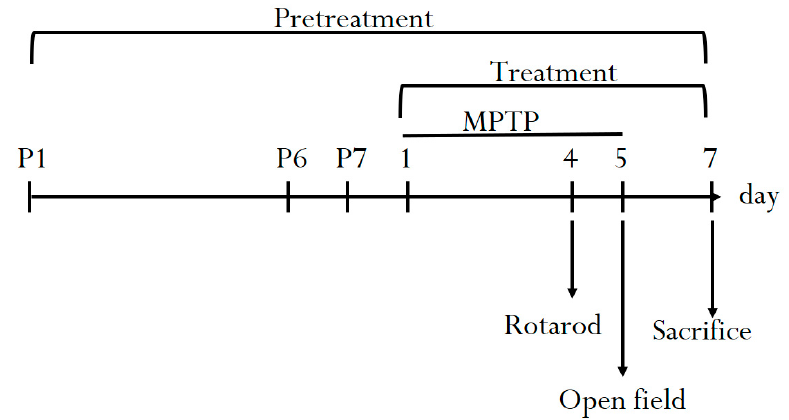
Figure 1. Schematic diagram of the experimental procedure. The pretreated group was administered S. chinensis (0.5, 1.5 and 5 g/kg, p.o.) for seven consecutive days before and MPTP administration (25